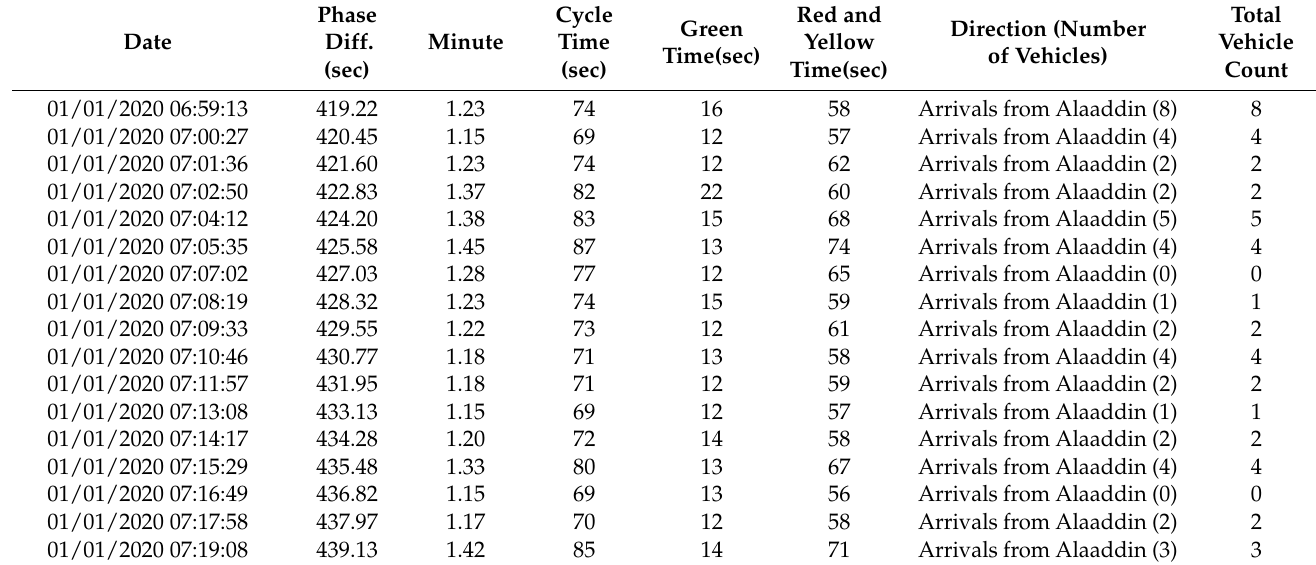
Table 9. Data example of the phase coming from Adalhan Junction Alaaddin direction